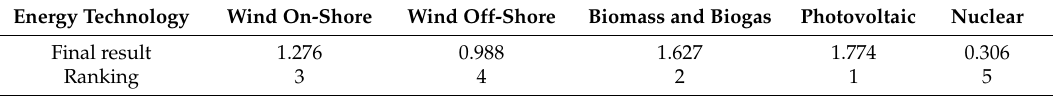
Table 8. Ranking of low-emission energy technologies on the basis of the FAHP